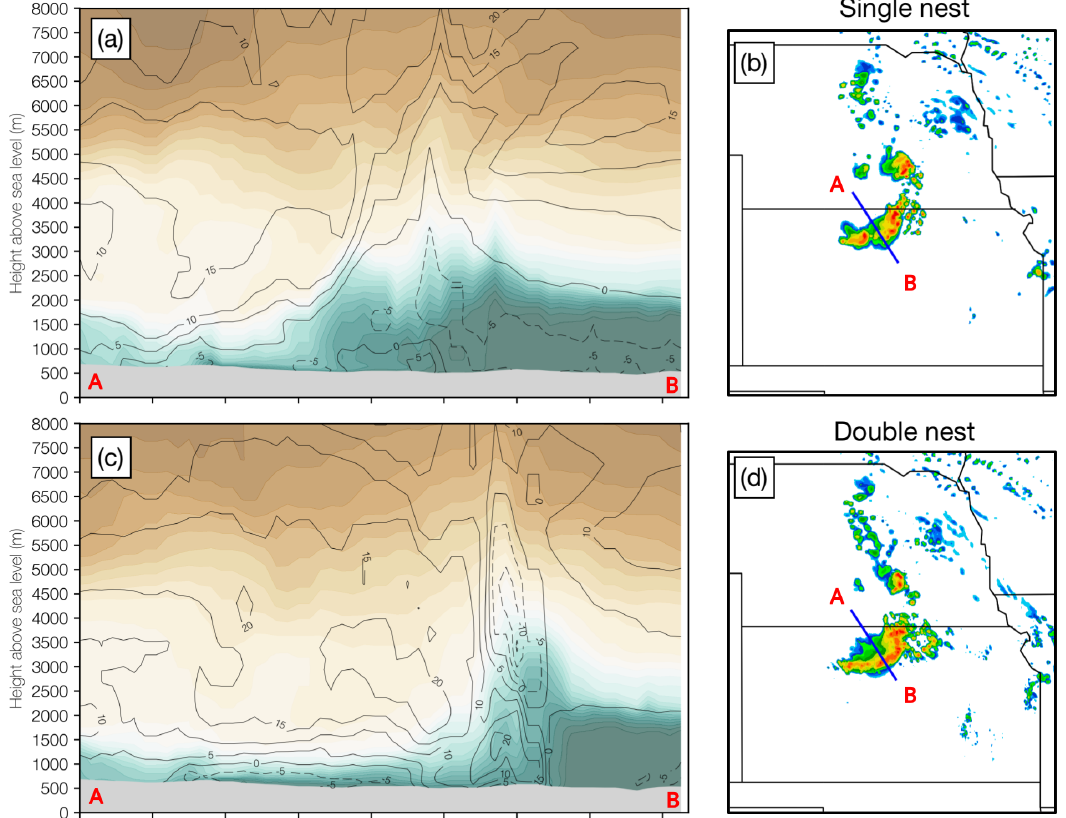
Figure 11. Cross-sections at 2100UTC on Day 1: ( a , c ) height against horizontal distance in the water mixing ratio perturbation field overlaid with the wind component parallel to the transect (contoured every 5 ms − 1 ; negative values, marked by dotted lines, indicate a component from right to left on the panel); and ( b , d ) latitude–longitude in the composite reflectivity field from the single- ( a , b ) and double-nest ( c , d ) control runs. The blue transects in the right panels, between points A and B, mark the path of the cross-sections shown in the left panels. Note the height–distance cross-sections ( a , c ) were averaged 6km (two grid points) in each direction normal to the cross-section